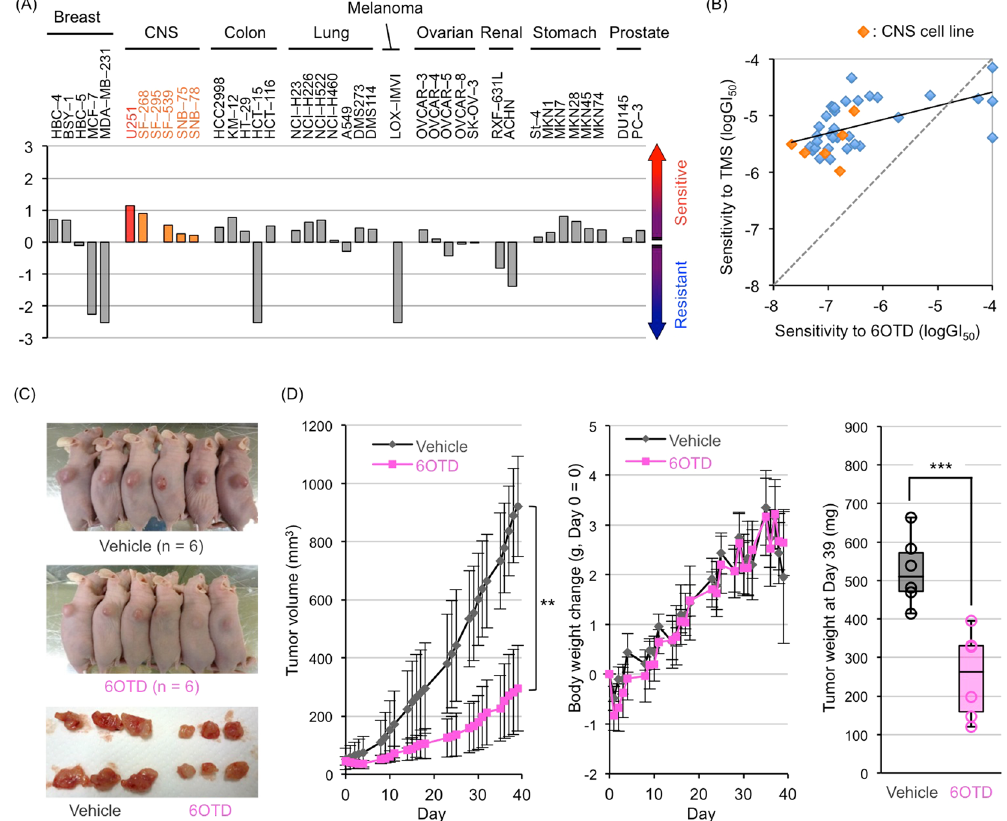
Figure 2. 6OTD inhibits the growth of glioma U251 cells in vitro and in vivo . ( A ) Growth inhibitory effect of 6OTD on the JFCR39 human cancer cell line panel. Zero in the vertical axis means the mean midpoint value of log [GI 50 ] of 6OTD for all the cell lines, and each bar means deviation of the log [GI 50 ] for each cell line from the mean midpoint value. Thus, cell lines that were relatively sensitive and resistant to 6OTD are indicated with the vertical bars above and below 0, respectively. CNS: central nervous system. Because the GI 50 value of SF-295 cells (290 nM) was exactly the same as the average value of all cell lines, the bar for this cell line cannot be seen in the graph (the value is zero). ( B ) Relationship between sensitivities of the cell lines to telomestatin (TMS) and 6OTD. Black solid line means linear approximation curve for the 39 data plots. Orange and blue symbols indicate CNS- and other organ-derived cancer cell lines, respectively. ( C ) Antitumor effect of 6OTD on U251 xenografts. Photos of vehicle ( top ) and 6OTD ( center )-treated mice at day 35 (n = 6) are shown. Bottom , dissected tumors after drug treatment. ( D ) Tumor volume ( left ), body weight change ( center ), and tumor weight at day 39 ( right ) in ( C ). Day 0 means the starting day of drug administration. Error bars mean SD. ** P < 0.01, ** * P <